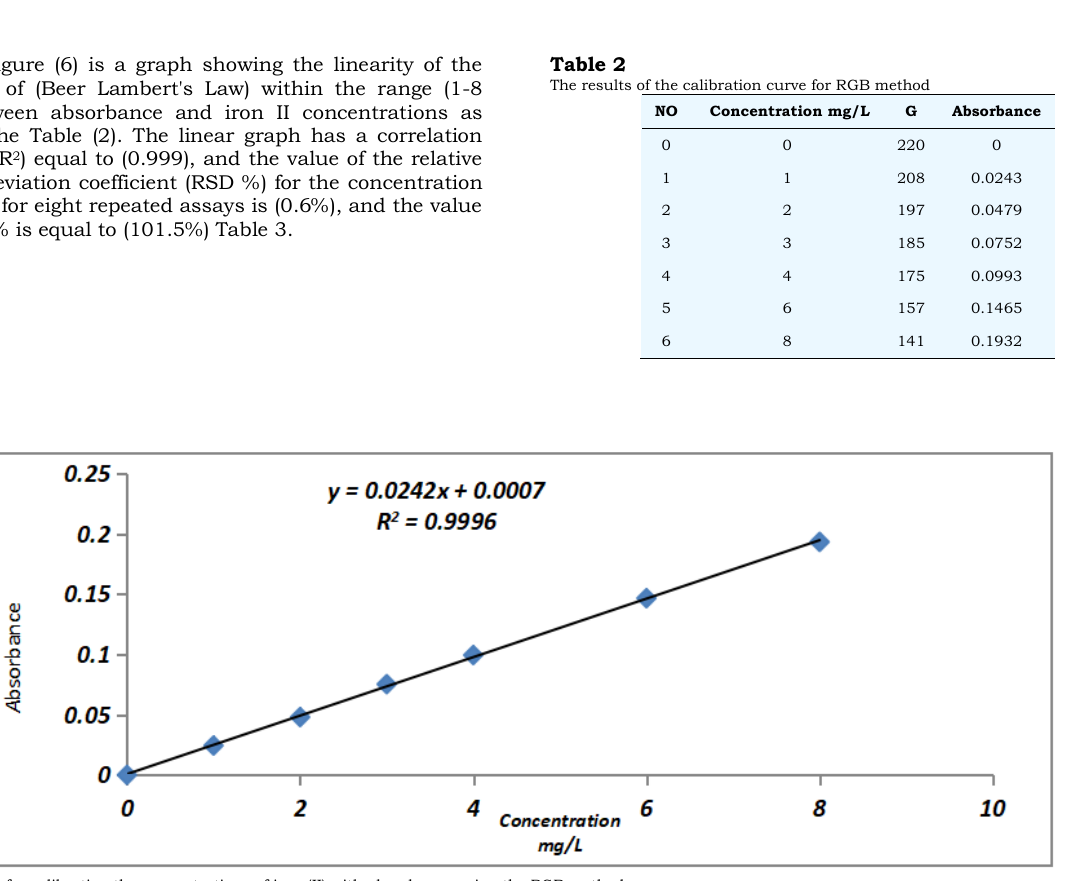
Fig. 6. Chart for calibrating the concentrations of iron (II) with absorbance using the RGB method